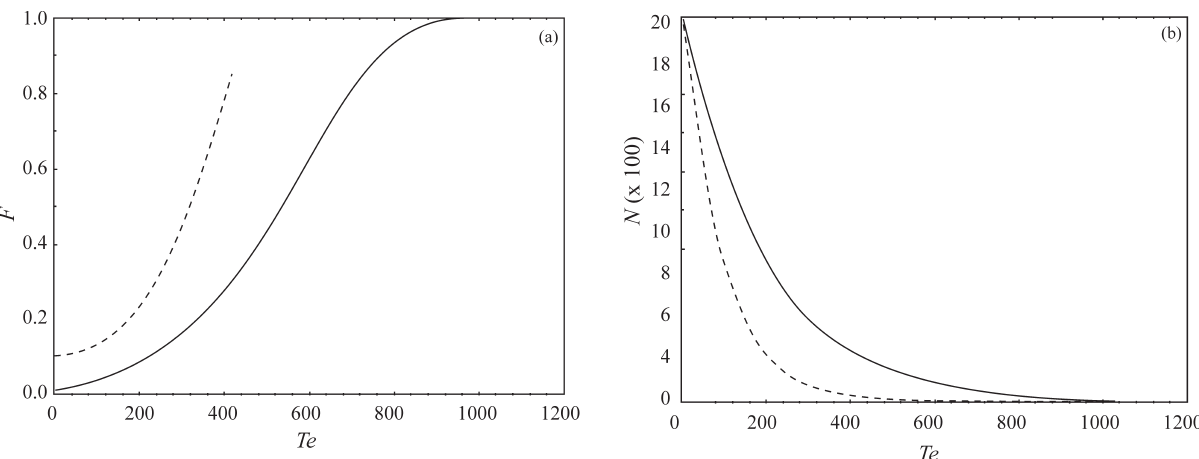
Figure 1 - Results of one simulation for the crab-eating fox population of the Parque Nacional das Emas. The variation in F -values (A) and in population size(B)throughtimeinthetwoextremescenariosareshown.Thesolidlineshowsthetrajectoryoftheparametersinthebestscenarioandthedashedline indicates the trajectories in the worst